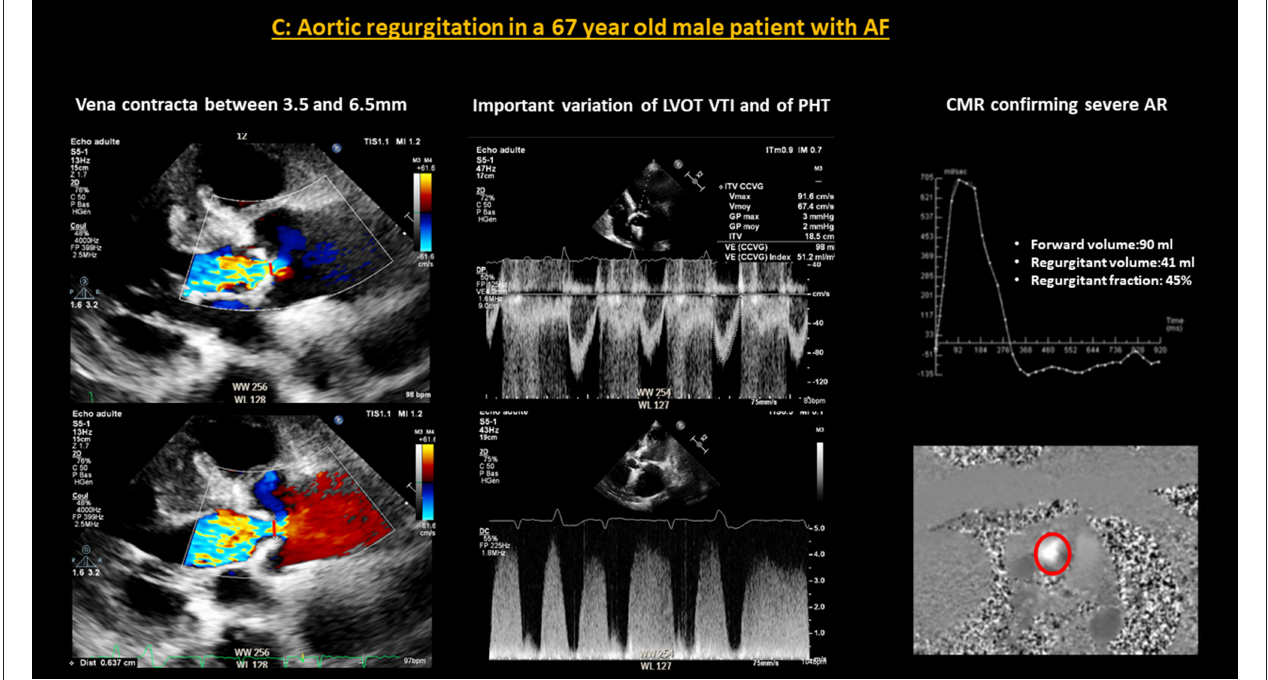
FIGURE 4 | Examples of difficult cases of echocardiographic evaluation of aortic valve disease in patients with AF. (A) A case of paradoxical low-flow low-gradient AS in a 71-year-old female patient with AF. The left ventricle is small with concentric remodeling and preserved LVEF and the aortic valve presents moderate to severe calcifications. There is a clear variation of the aortic flow according to the cardiac cycles. The MPG is low, calculated at 30mm Hg and the SVi is averaged at 32 ml/m ² , in favor of a paradoxical low-flow, low-gradient AS. After electrical cardioversion, and the restoration of SR, the cycles no longer fluctuate, the SVi has normalized to 46 ml/m ² and the MPG is high at 43 mmHg. The AVA remained stable at around 0.7cm ² before and after cardioversion. (B) A case of classical low-flow low-gradient AS in a 75-year-old male patient with AF. There is a left ventricular dysfunction, with a LVEF estimated at 33%. The flows vary slightly according to the cardiac cycles. The MPG is low, averaged at 28 mmHg as well as the SVi which is estimated at 25 mml/m ² . The cardiac CT-scan is in favor of a severe AS because the calcium score is very high at 3,220 and the aortic valve planimetry finds 0.95cm ² . (C) A case of aortic regurgitation in a 67-year-old male patient with AF. It is difficult to distinguish between a moderate and a severe AR on echocardiography because of the marked variation of the parameters (vena contracta, LVOT VTI and PHT) between cardiac cycles. Evaluation by phase-contrast CMR, which is less disturbed by AF than echocardiography, leads to the conclusion of severe AR with a calculated regurgitation fraction of 45%. AF, atrial fibrillation; AR, aortic regurgitation; AS, aortic stenosis; AVA, aortic valve area; CMR, cardiac magnetic resonance; LVEF, left ventricular ejection fraction; LVOT VTI, left ventricular outflow tract velocity time integral; MPG, mean pressure gradient; PHT, pressure half time; SR, sinus rhythm; SVi, stroke volume